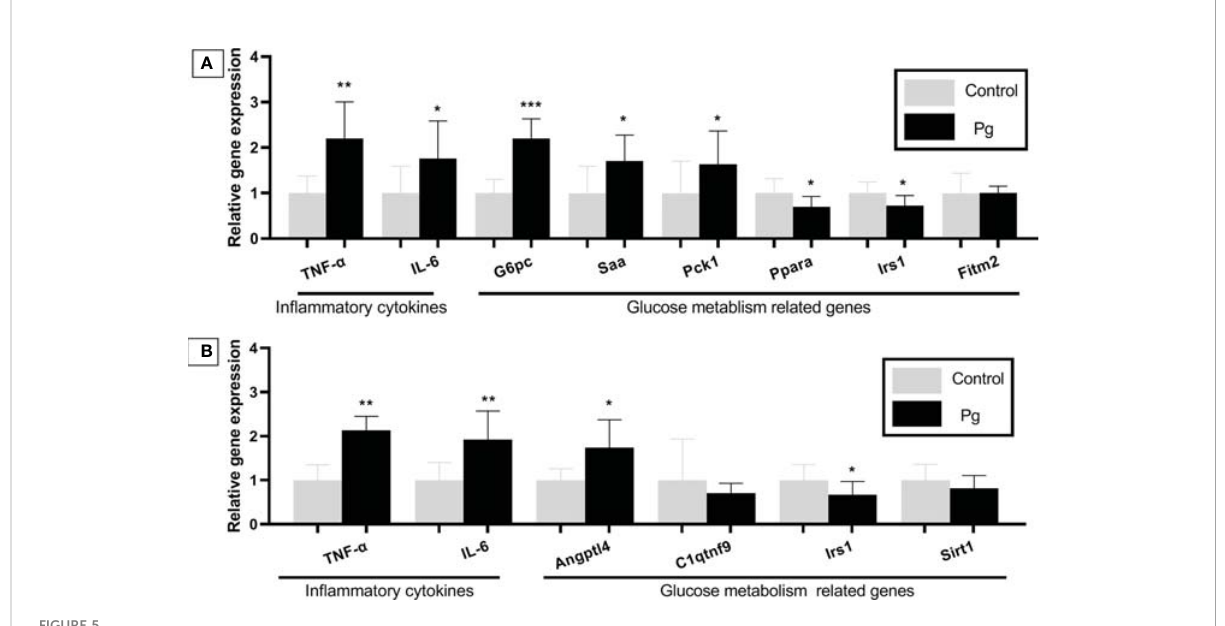
FIGURE 5 Effects of the oral administration of Porphyromonas gingivalis on the gene expression of in fl ammatory cytokines and the expression of the glucose metabolism-related genes in the liver (A) and adipose tissue (B) of mice in the P. gingivalis -administered group and the control group. The relative mRNA expressions of the genes of interest were normalized to the relative quantity of glyceraldehyde 3-phosphate dehydrogenase ( GAPDH ) mRNA. * p < 0.05, ** p < 0.01, *** p < 0.001. N = 6. Data are expressed as the mean ±